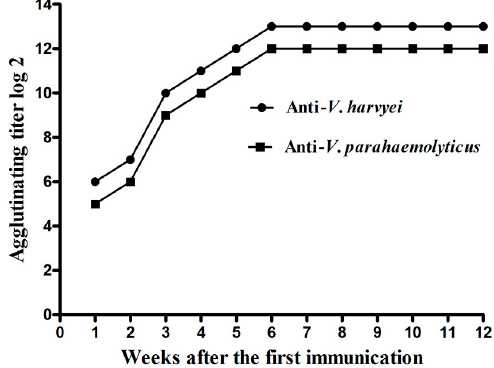
Figure 1. The titer of anti- V. harveyi and anti- V. parahaemolyticus IgY in the egg yolk detected by the tube agglutination test.